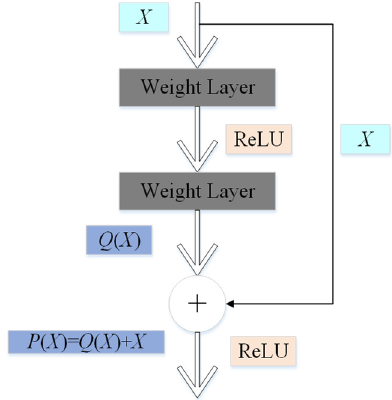
Figure 3. The structure of the residual learning.